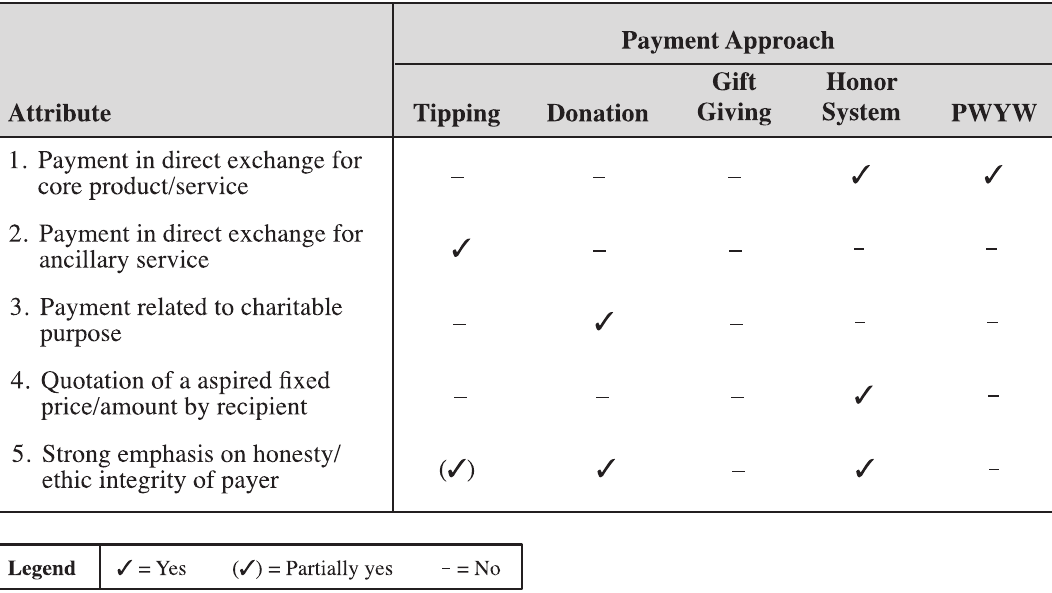
Fig. 1. Profile of voluntary payment mechanisms in commercial transactions on moral